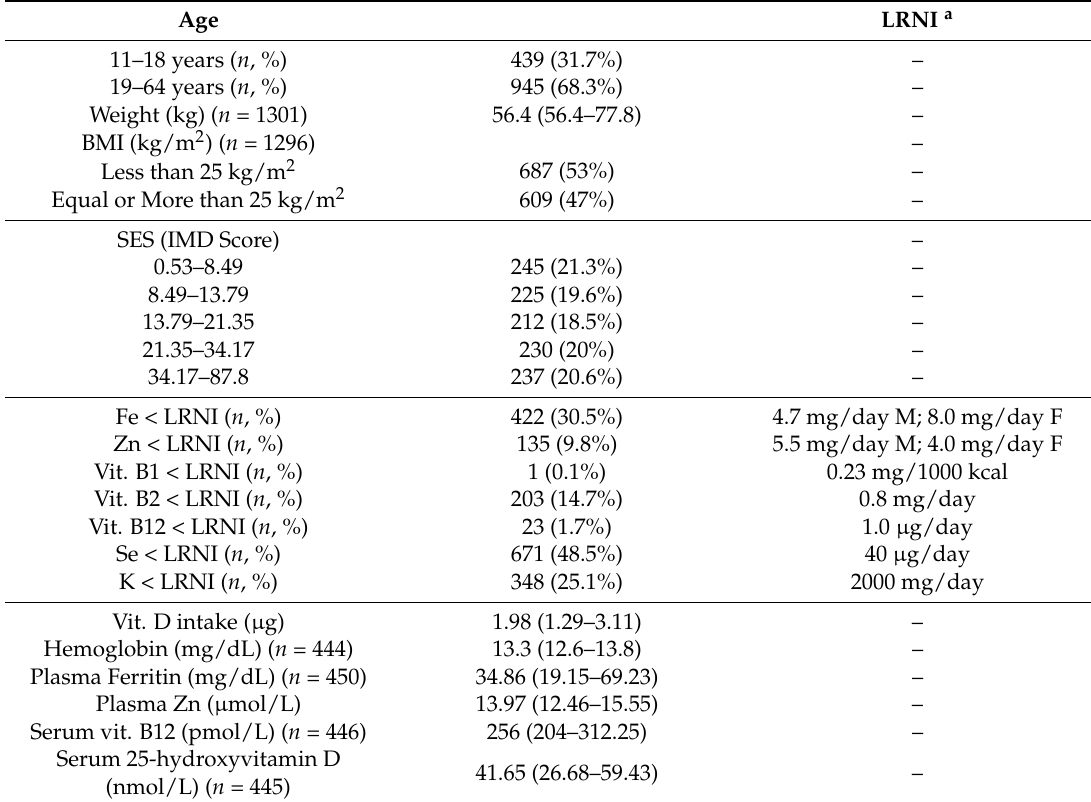
Table 1. Characteristics of study subjects ( n =